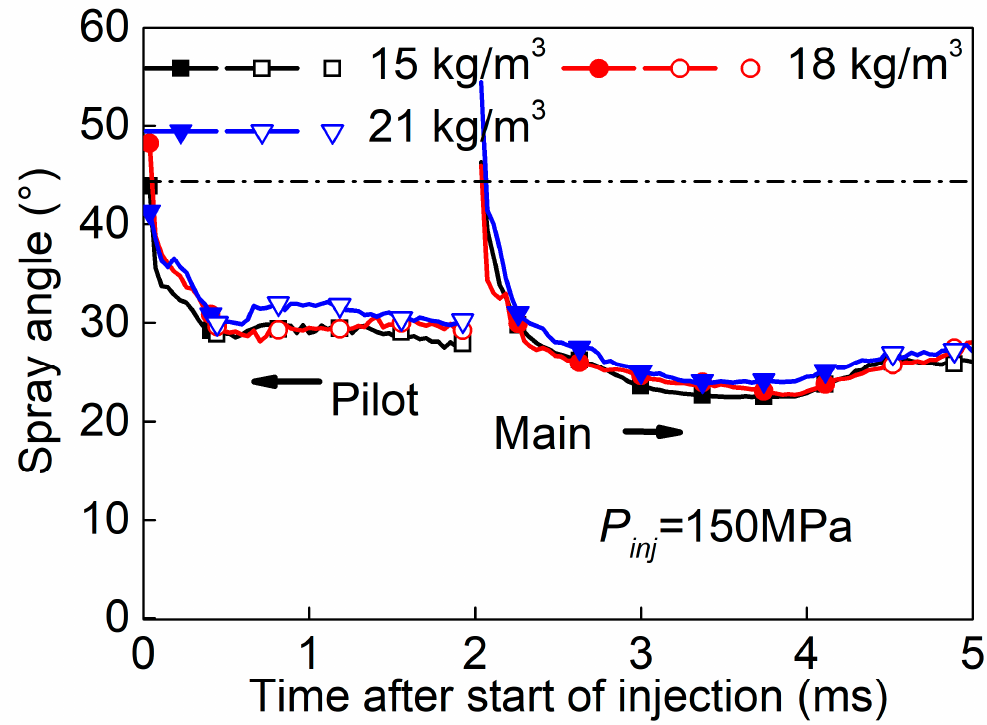
Figure 15. Results of spray angle evolvements when applying the pilot-main injection strategy under various surrounding gas densities.